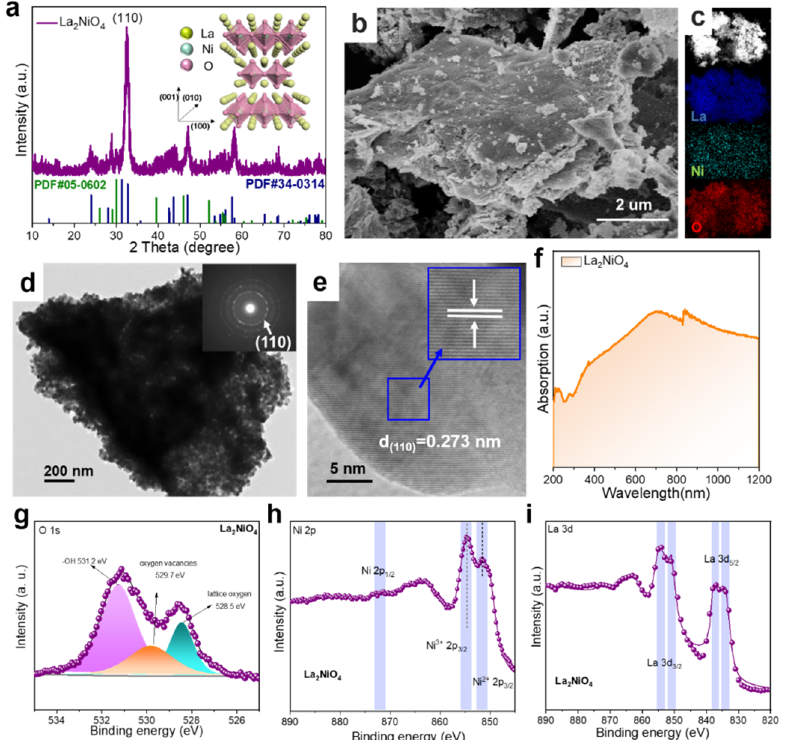
Figure 2. ( a ) XRD patterns of La 2 NiO 4 . ( b – e ) SEM, SEM-EDS mapping, TEM and HRTEM images of La 2 NiO 4 . The insets in ( d ) show the corresponding SAED patterns. UV-vis absorption spectra ( f ) of La 2 NiO 4 . XPS spectra of ( g ) O1s, ( h ) Ni 2p, and ( i ) La 3d for obtained La 2 NiO 4